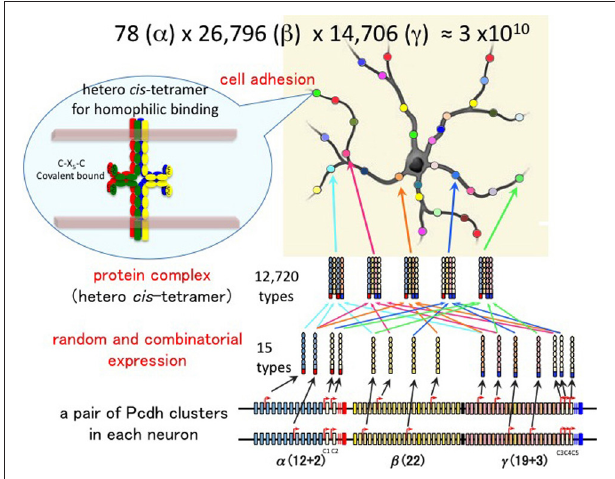
FIGURE 4 | Individuality of neurons determined by the random expression of clustered Pcdh isoforms and the random production of heteromultimeric cis -tetramers. From each clustered Pcdh cluster allele, 1 of the α , 2 of the β , and 2 of the γ isoforms are randomly expressed in combination. From the two alleles in each neuron, 2 of the α , 4 of the β , and 4 of the γ isoforms are randomly expressed in combination and with repetition, e.g., sometimes the same isoform is chosen from both alleles. Thus, the 78 possible combinations from 12 ( α ), 26,796 from 22 ( β ), and 14,706 from 19 ( β ) yield approximately 3 × 10 10 variations that could be expressed by individual neurons. The five C-type isoforms are constitutively expressed from both alleles in each neuron. Therefore, a total of 15isoforms is expressed in each neuron, 10 (2 α + 4 β + 4 γ ) random and five constitutive isoforms. From 15isoforms, 12,720 types of cis -tetramers are possible by combination with repetition and considering the topological variations (see Figure 5 ). The protein structure of the heteromultimeric cis -tetramers has not been revealed yet. The C-X 5 -C motif is conserved among all clustered Pcdh isoforms and is important for forming the cis -tetramers Schreiner and Weiner (2010). Actually the clustered Pcdh proteins are localized as their protein dots in neuritis Phillips et al. (2003); Murata et al. (2004), and also shown that over expression of intact and truncated Pcdh- γ isoform can inhibit synaptogenesis Femandez-Monreal et al.